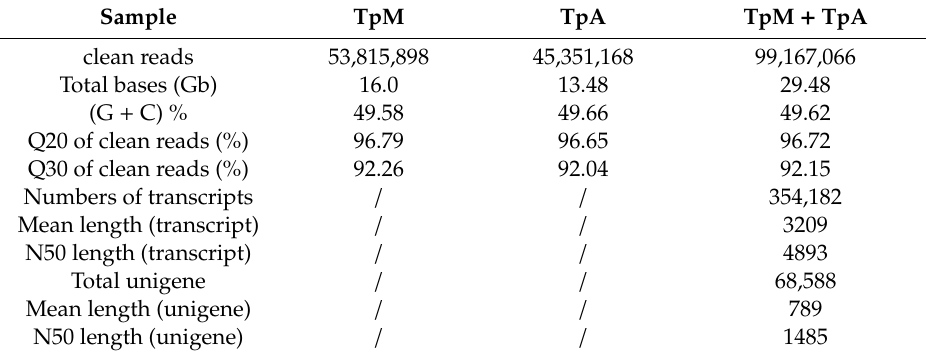
Table 1. Summary of statistics of illumine transcriptome sequencing and assembly for T. pisiformis